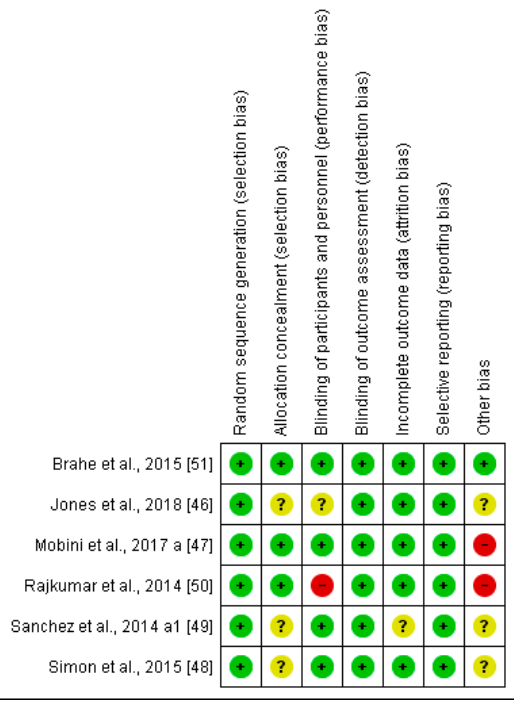
Figure 7. Risk of bias summary of CT: review authors’ judgments about each risk of bias item for each included study low risk ( − : green cycle), high risk ( + : red cycle), or unclear risk (?: yellow